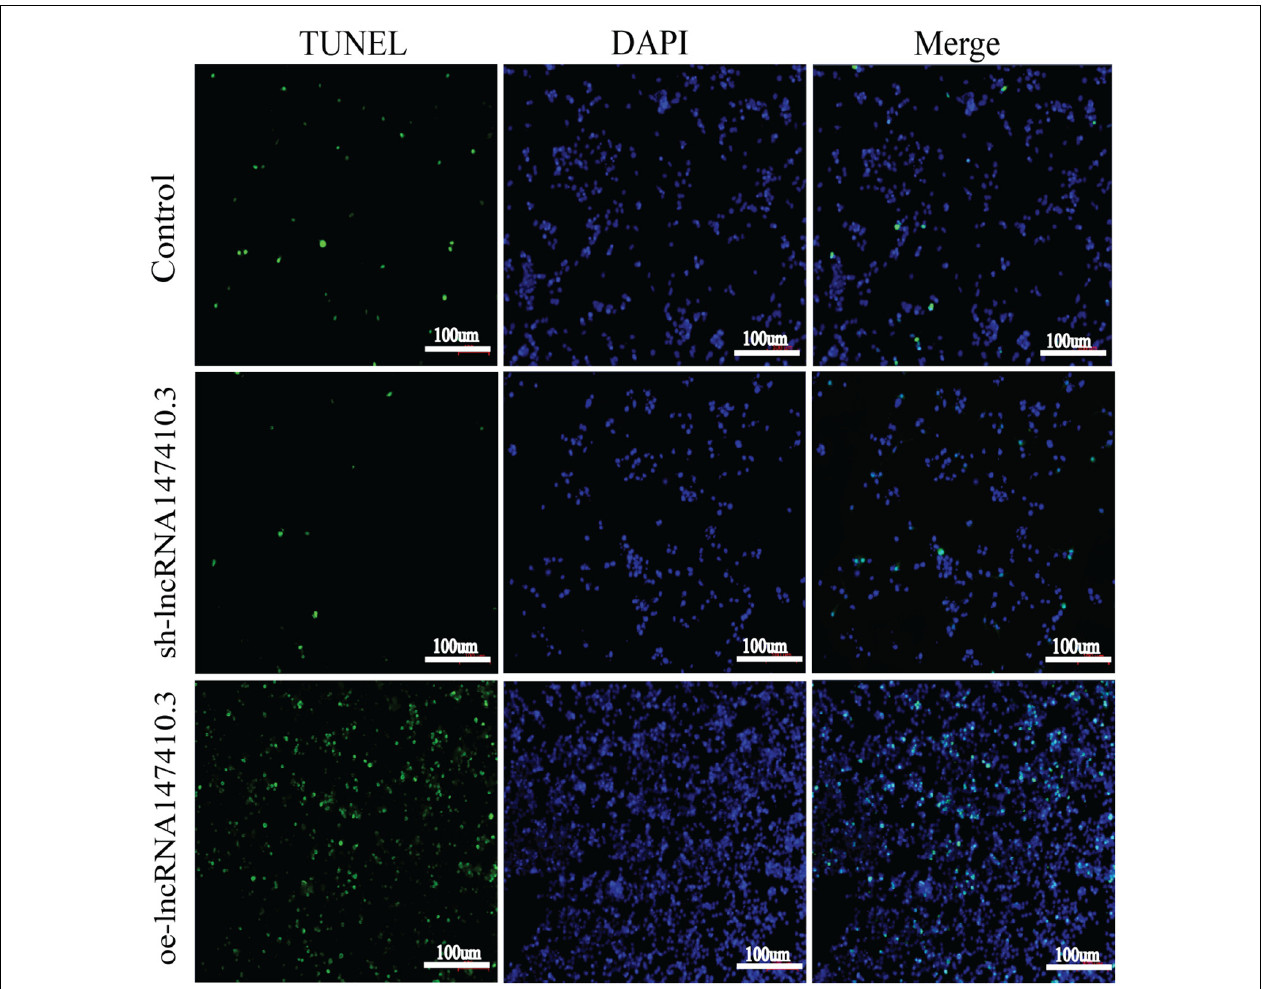
FIGURE 6 | The effect of lncRNA147410.3 on the apoptosis of BV-2 cells was detected by TUNEL assay cell apoptosis of BV-2 cells transfected with control plasmid, sh-lncRNA147410.3 and oe-lncRNA147410.3 was analyzed by TUNEL assay. The coverslips were observed and images are collected by fluorescent microscopy. Apoptosis cells labeled with FITC show green fluorescence. DAPI (blue) was used for